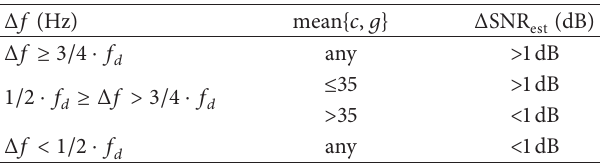
Table 2: Relations between the spectral width, the PSD for the end frequencies, and the SNR difference with respect to the static